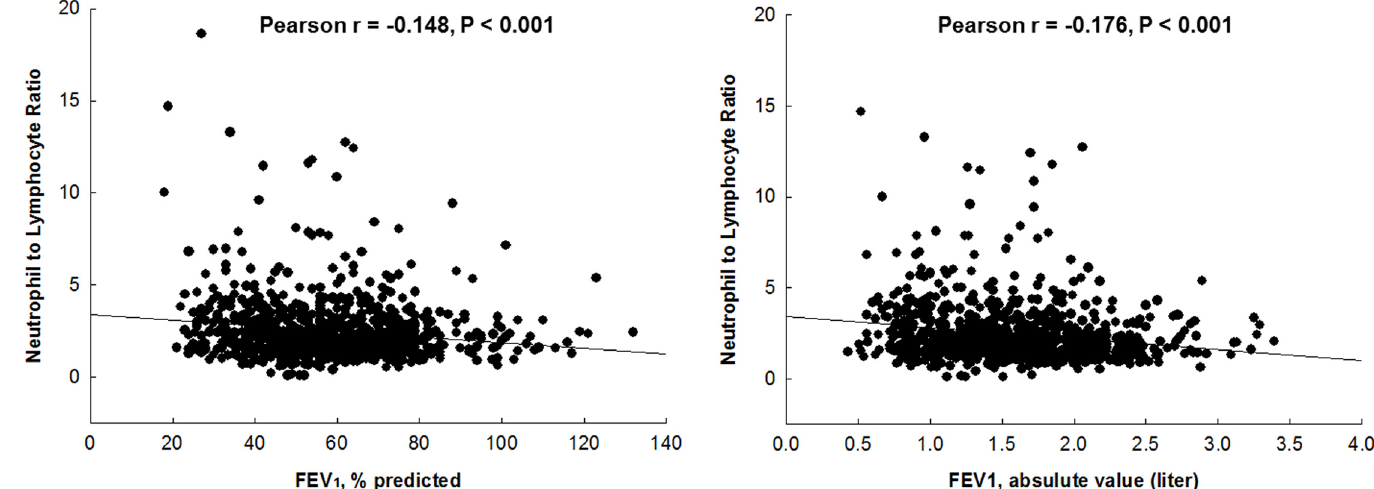
Fig 2. The relationship between neutrophil to lymphocyte ratio and lung function.